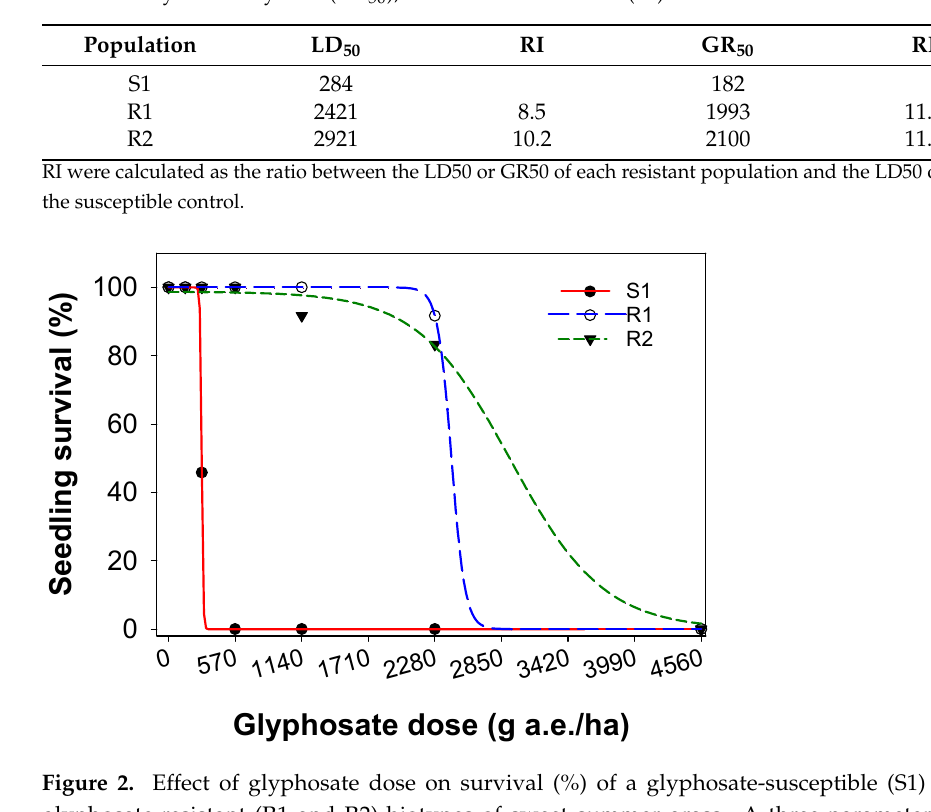
Table 1. Estimated glyphosate dose required to kill 50% of the plants (LD 50 ), glyphosate dose required to reduce dry matter by 50% (GR 50 ), and resistance indices (RI).